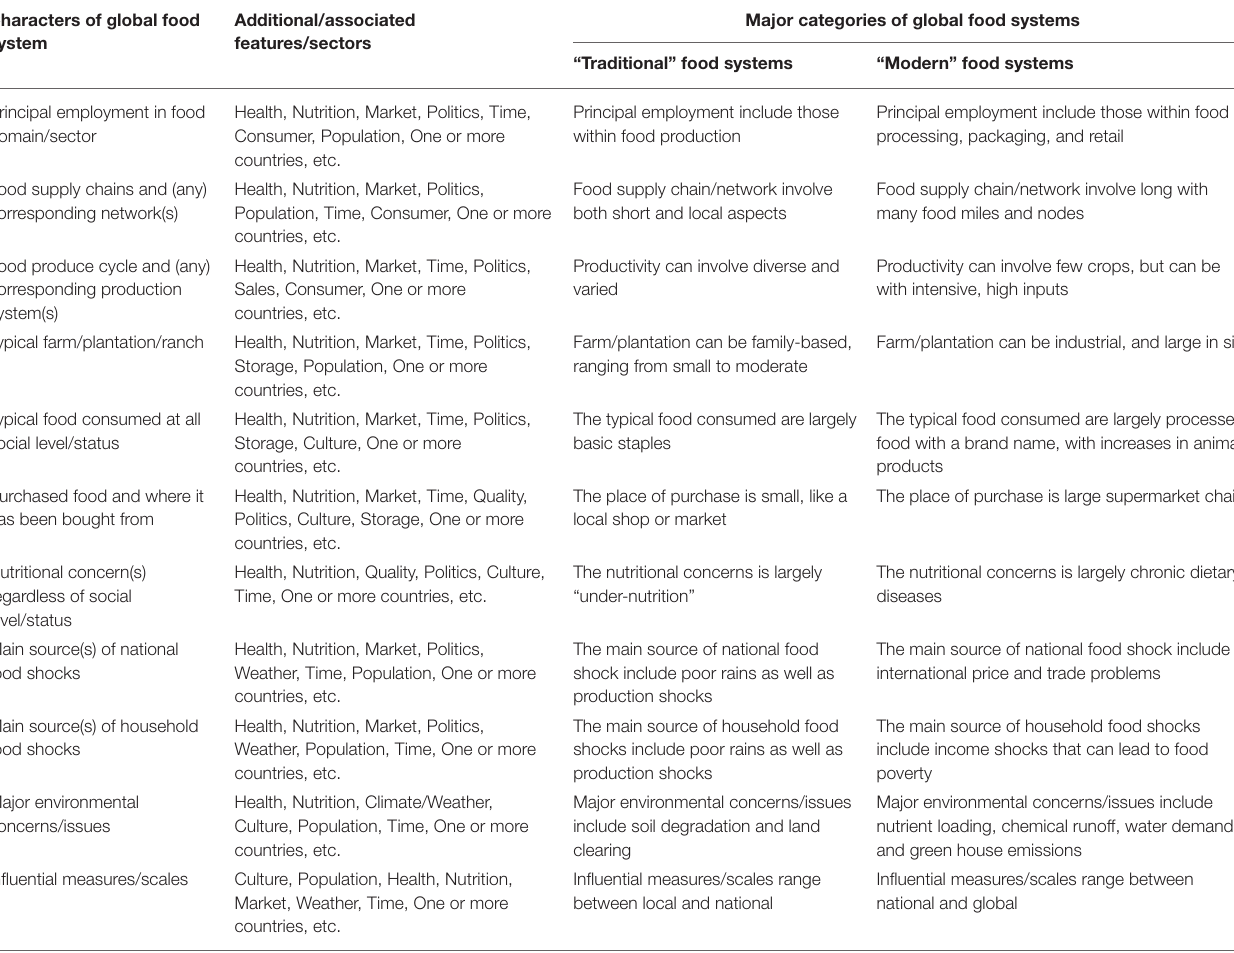
TABLE 1 | Some character comparisons of major categories of global food systems. Characters of global food Additional/associated system